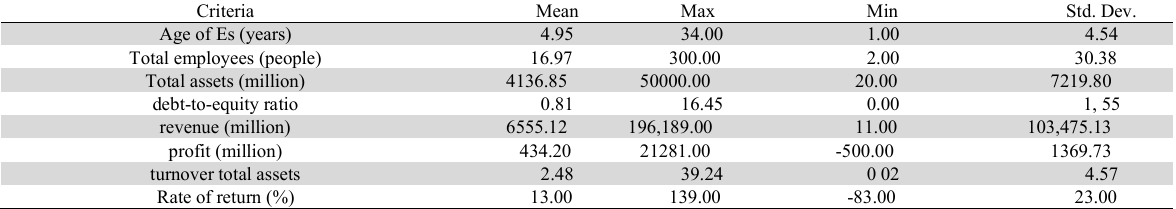
Descriptive characteristics of SMES in the survey Criteria Mean